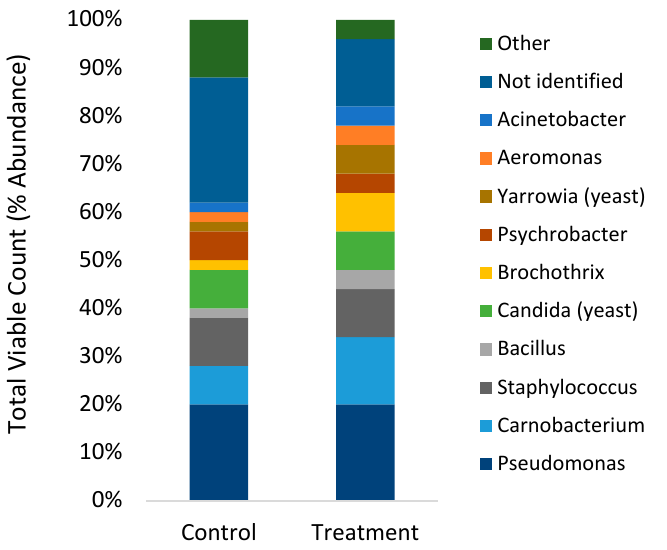
Figure 3. Relative abundance of viable microbes from the gut digesta ( n = 10) from rainbow trout cultured on TSA plates and identified by MALDI-TOF.